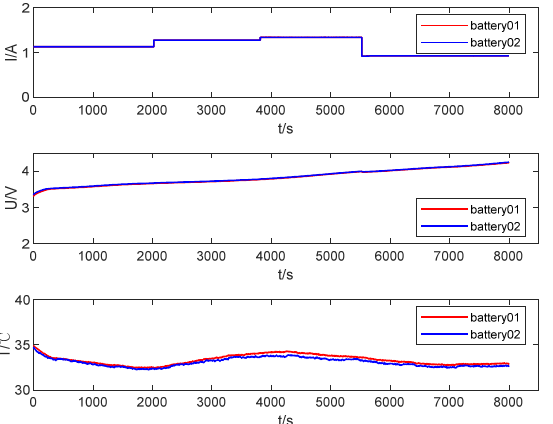
Figure 10. The experimental results of the three-stage optimized constant current charging strategy.